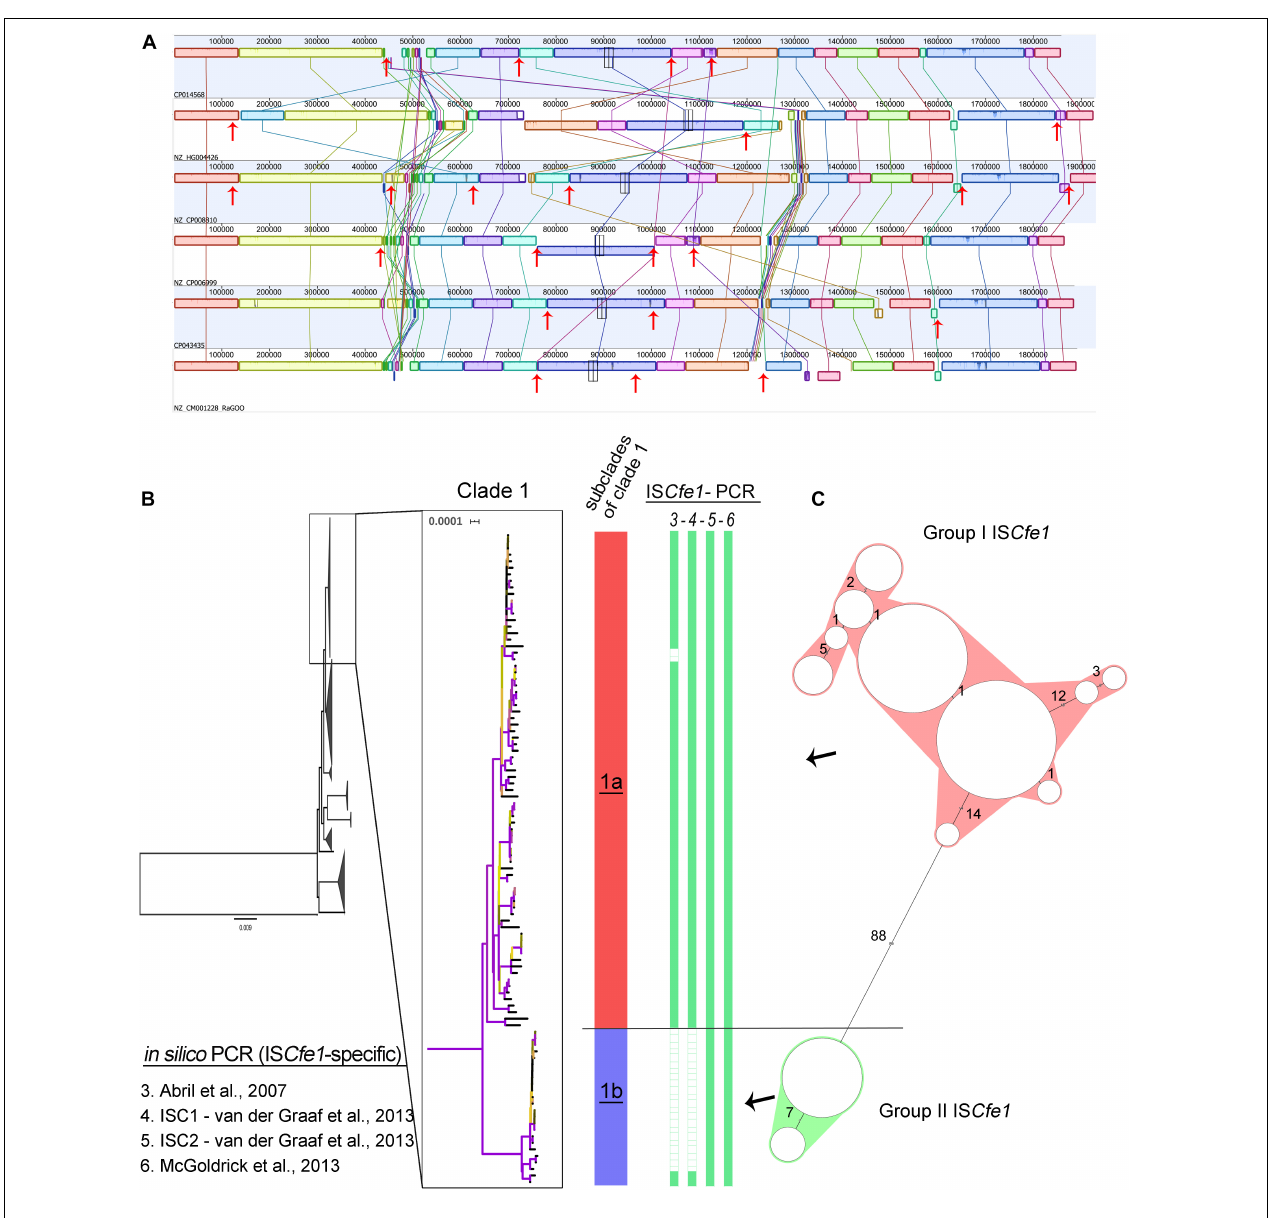
FIGURE 3 | The presence of the IS Cfe1 insertion sequence and its sequence variability. (A) Mauve alignment of the chromosomes from the six complete Campylobacter fetus genomes in clade 1 showing the location of the IS Cfe1 paralogues across the chromosomes (red arrows) and their frequent association with inversions and shifts of the chromosomal locally collinear blocks. (B) A close-up view of the phylogenetic clade 1 shows two distinct subclades (1a and 1b). Two IS Cfe1 groups based on the cluster analysis of the IS Cfe1 sequences (C) were reflected by the phylogenetic structure of clade 1. Group I IS Cfe1 is present in the subclade “1a” while group II of IS Cfe1 is present in subclade “1b”.